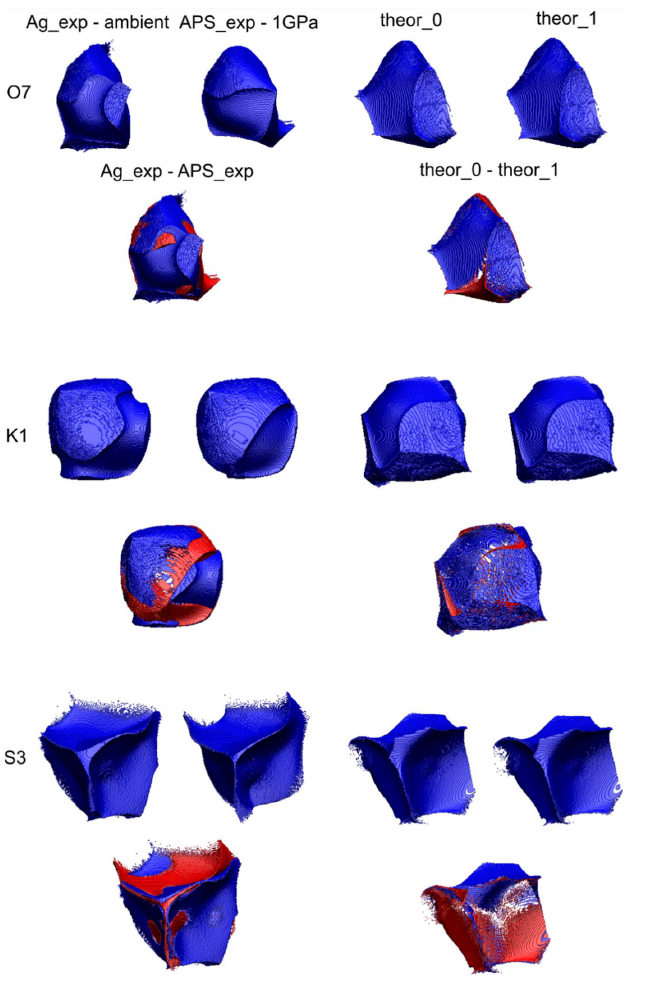
Figure 11 Comparison of selected atomic basins: O(7), K(1) and S(3) and their difference maps for experimental and theoretical data.